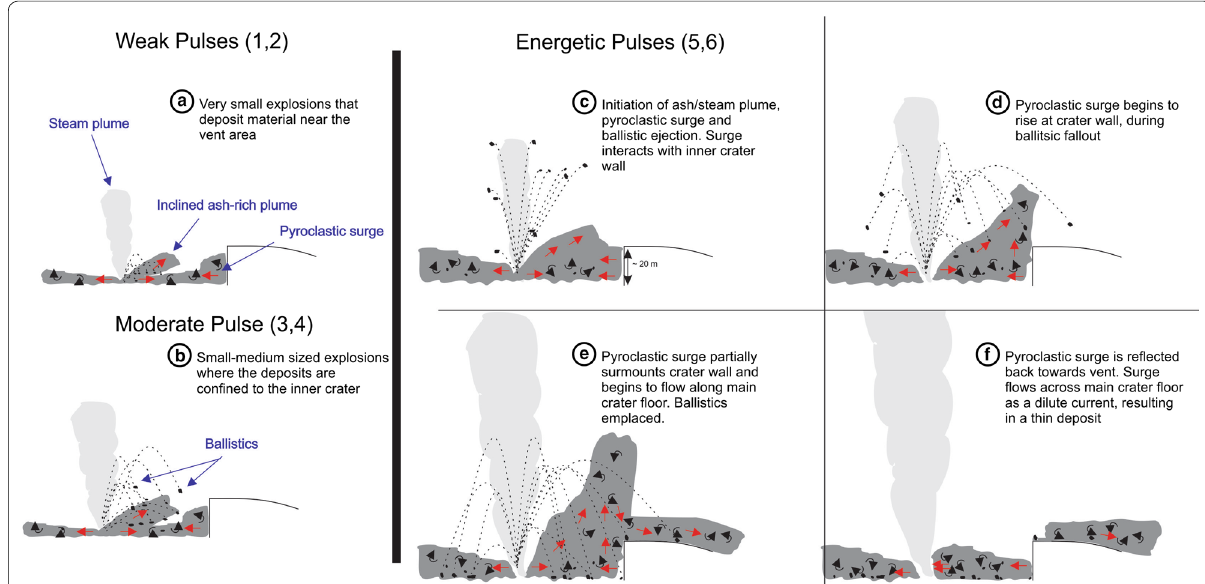
Fig. 14 Conceptual diagram of the eruption sequence derived from both deposit data and geophysical analysis (Walsh et al. 2019). Six pulses are recorded by the seismo-acoustic analysis and at least two of those are reasonably energetic (pulses 5 and 6). Pulses 1, 2, 3 and 4 are too weak to deposit ejecta beyond the inner crater ( a ) and ( b ). Pulses 5 and 6 are both energetic, and their vents were inclined to the east ( c ). The inclined explosions generated a coupled ballistic and pyroclastic surge that partially encountered and was contained by the inner crater wall. For the surge component, the crater wall caused significant upflow causing significant atmospheric entrainment and deposition of ash part way up the crater walls. The variable burial of ballistic ejecta and the lack of abundant impact craters suggests that ballistics were falling onto the surge ( e ) and ( f